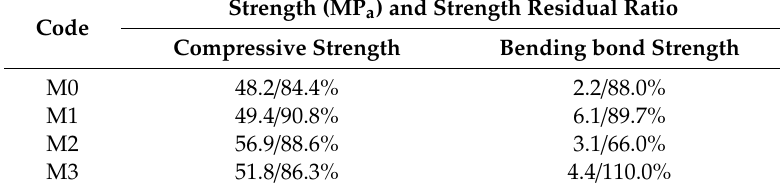
Table 4. The short-term water maintains strength and strength residual ratio of MKPC mortar mixed with mineral mixed